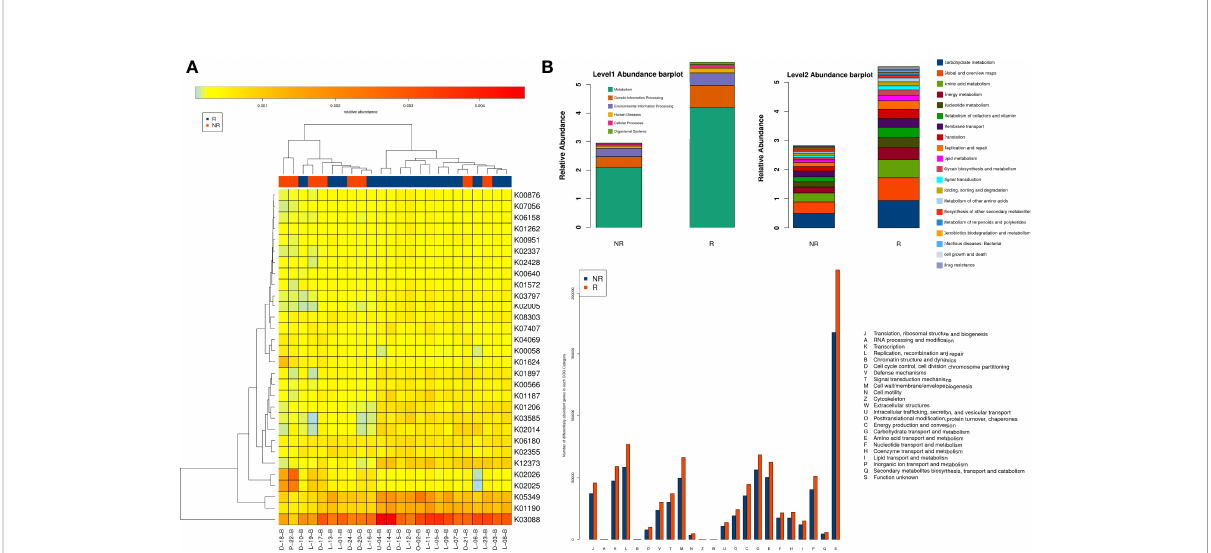
FIGURE 6 Comparison of functional genes and metabolic pathways at 6 weeks in the R group (n = 16) and the NR group (n = 8). (A) Heatmap of samples and differential KOs based on LEfSe analysis. (B) The gut microbiota of the R group was more enriched in biochemical and metabolic pathways at different functional levels, as evaluated with the KEGG and EggNOG